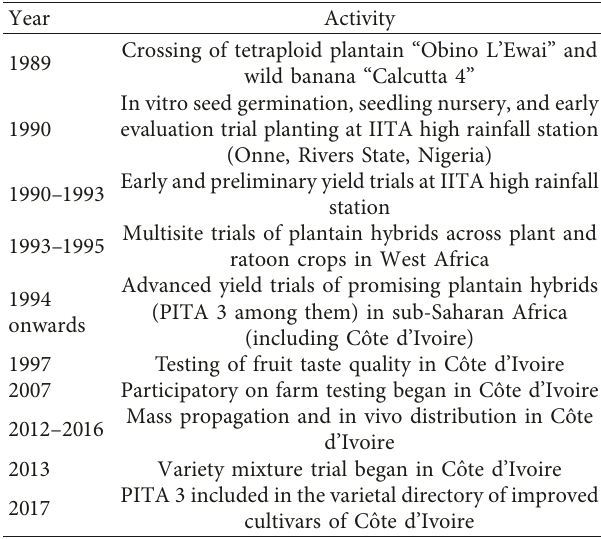
Table 1: The making of PITA 3: from crossing (1989) to cultivar release in Cˆote d’Ivoire